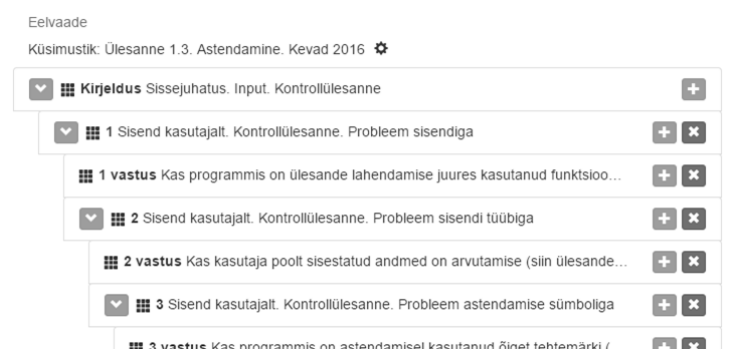
Figure 4 . Overview of created troubleshooter